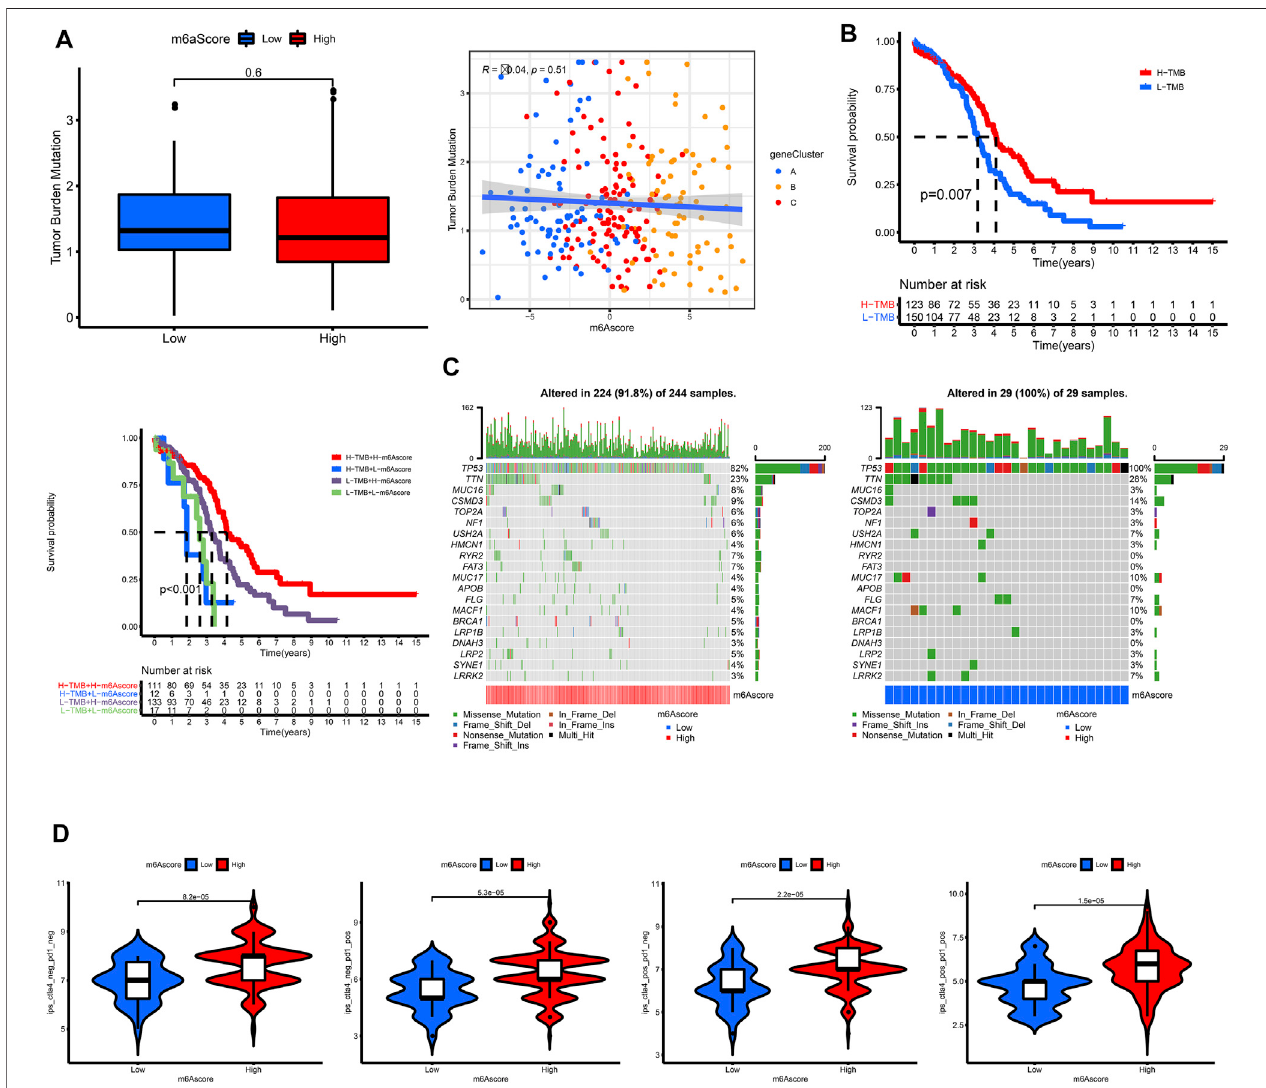
FIGURE7| Characteristicsofm6Amodi fi cationandtumorsomaticmutationinTCGA. (A) ThecorrelationofTMBandm6Ascore. (B) Survivalanalysisforsubgroup patientsstrati fi edbybothTMBandm6AscoreusingKaplan-Meiercurves. (C) Thewaterfallplotoftumorsomaticmutationestablishedbythosewithhighm6Ascoreand low m6Ascore. (D) The association between m6Ascore and immunotherapy.